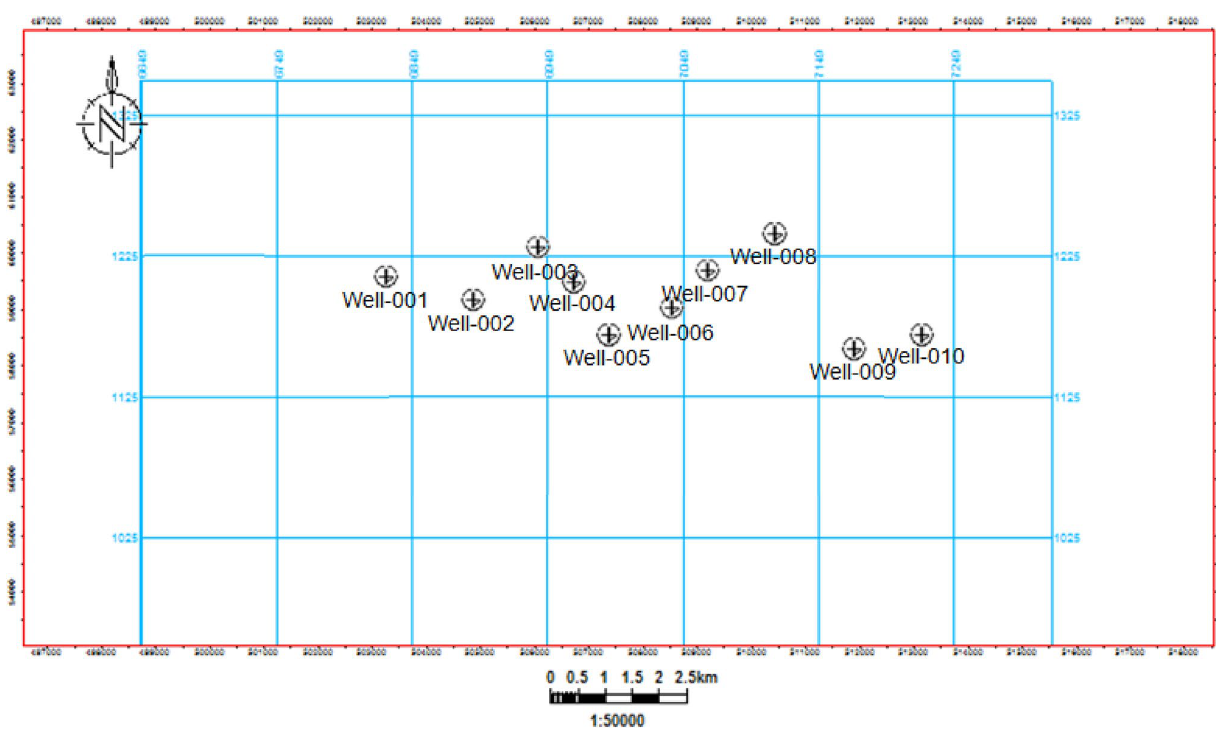
Fig. 4 Base map showing the distribution of wells in the